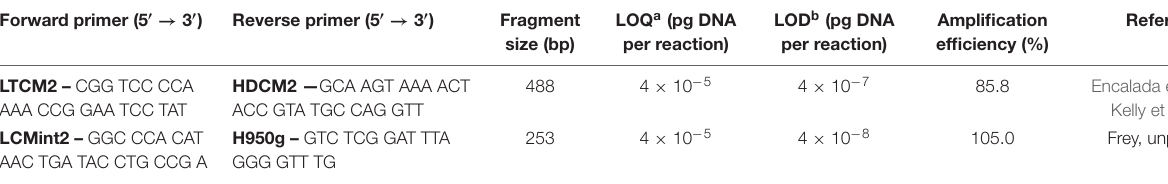
TABLE 1 | Characteristics of primer pairs selected for assay development. Forward primer (5 (cid:48) → 3 (cid:48) ) Reverse primer (5 (cid:48) → 3 (cid:48) )